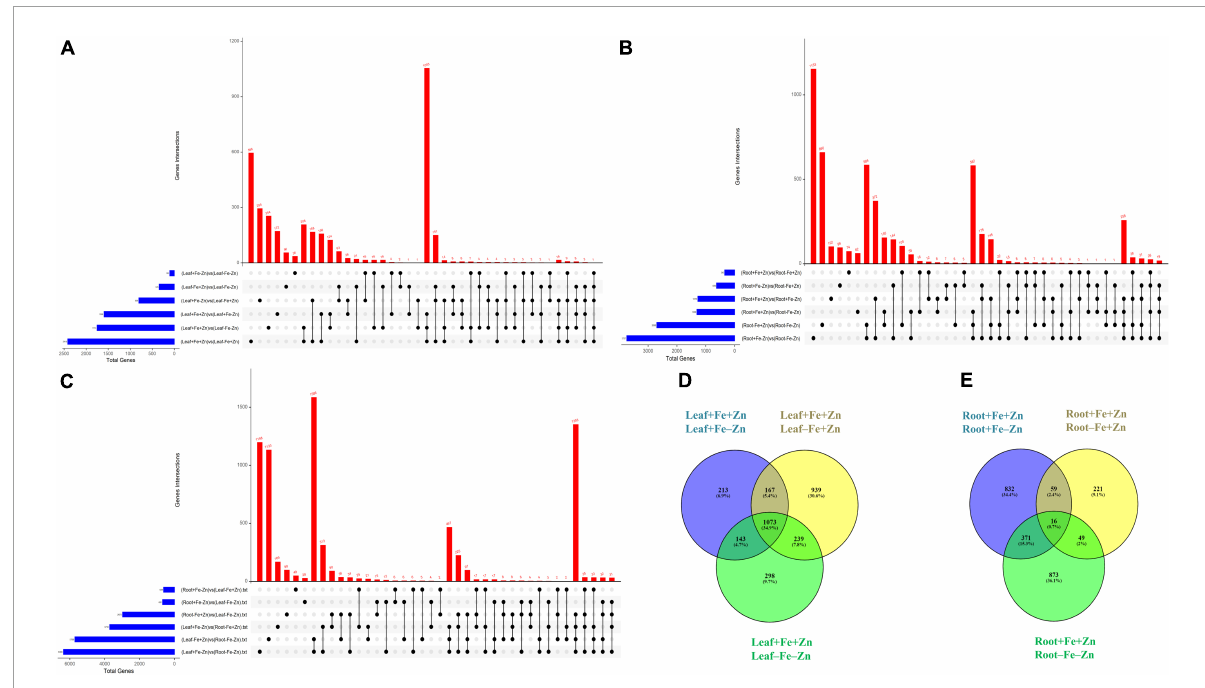
FIGURE1 Upset plot illustrating the intersections between the set of DEGs identified in response to –Fe, –Zn, –Fe–Zn stresses in (A) leaf, (B) root, and (C) leaf and root. The blue bar on the left side indicates the total number of DEGs expressed under specific stress treatments and the red bar on the right side indicates the DEGs unique to a specific treatment and between the treatments. Dots connect by a black line on the bottom panel indicate the intersections between the treatments and the representation of stress-specific and common DEGs in response to –Fe, –Zn, –Fe –Zn stresses in (D) leaf and (E)